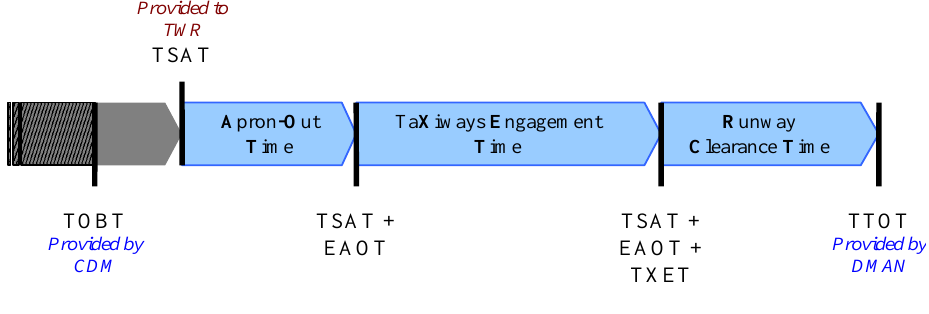
Figure 2. Reference Estimated Taxi-Out Time (EXOT) breakdown. TWR; TSAT, Target